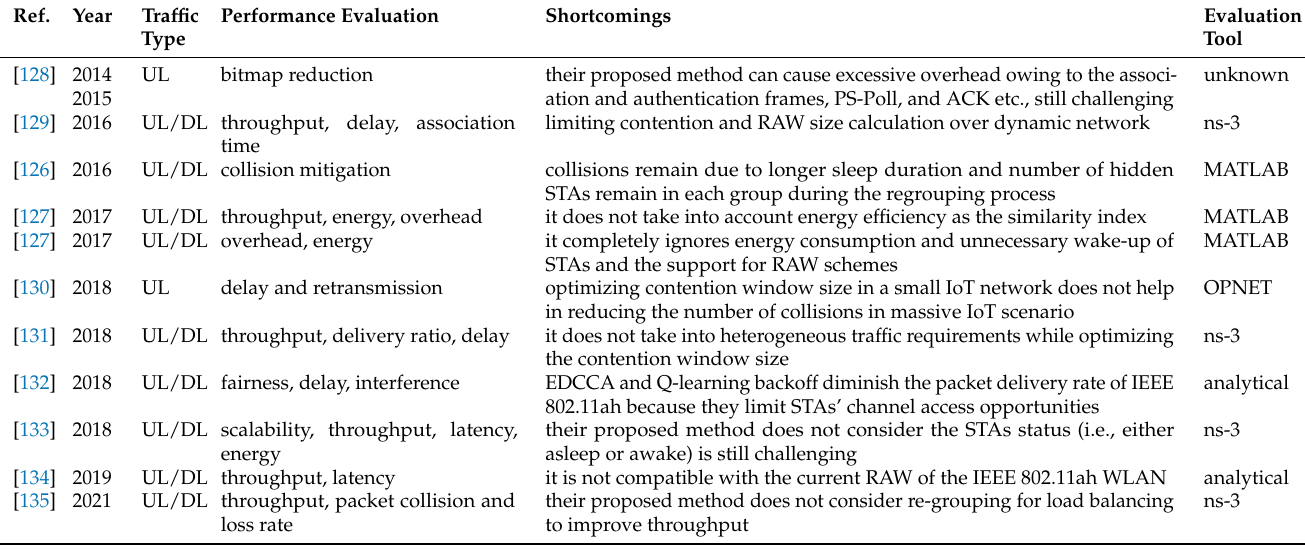
Table 6. Current solutions on association identifier (AID), overhead, and backoff in IEEE 802.11ah WLAN with